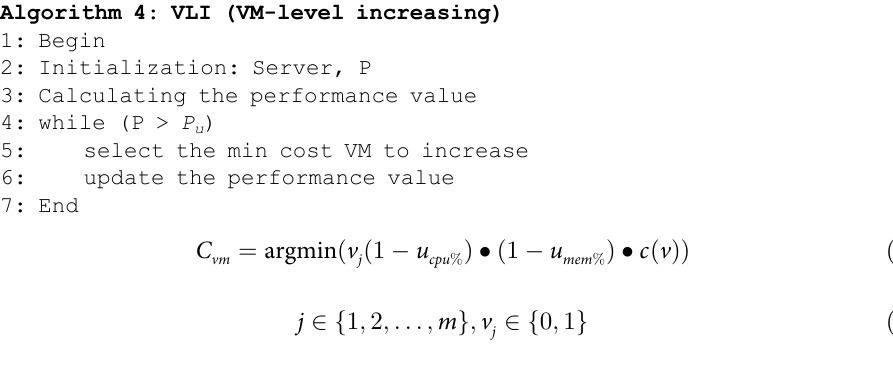
Algorithm 4 : VLI (VM-level increasing)